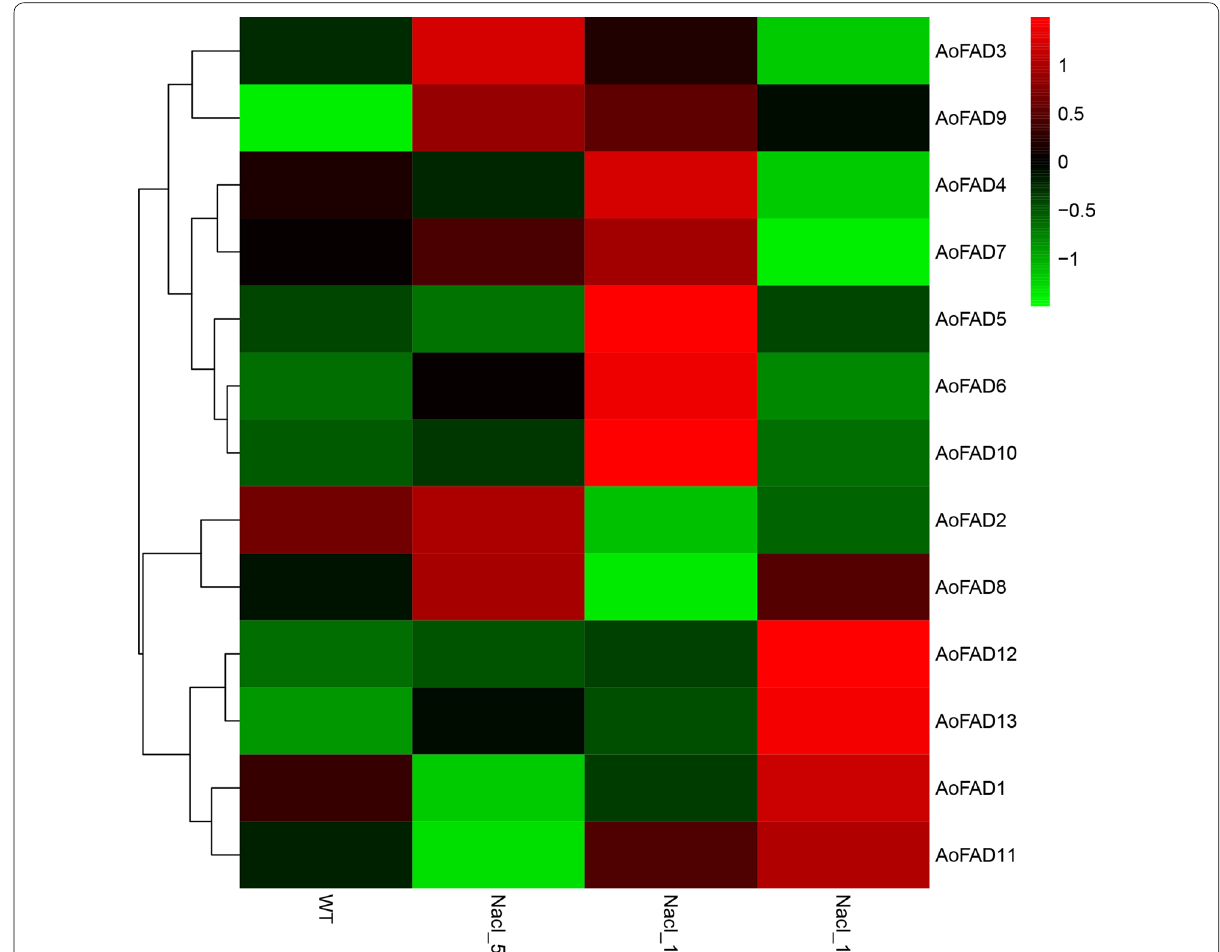
Fig. 5 Expression of the AoFAD genes under salt stress. WT, NaCl_5, NaCl_10 and NaCl_15 indicated samples cultivated in PDA medium supplied with 0, 5, 10 and 15% NaCl,